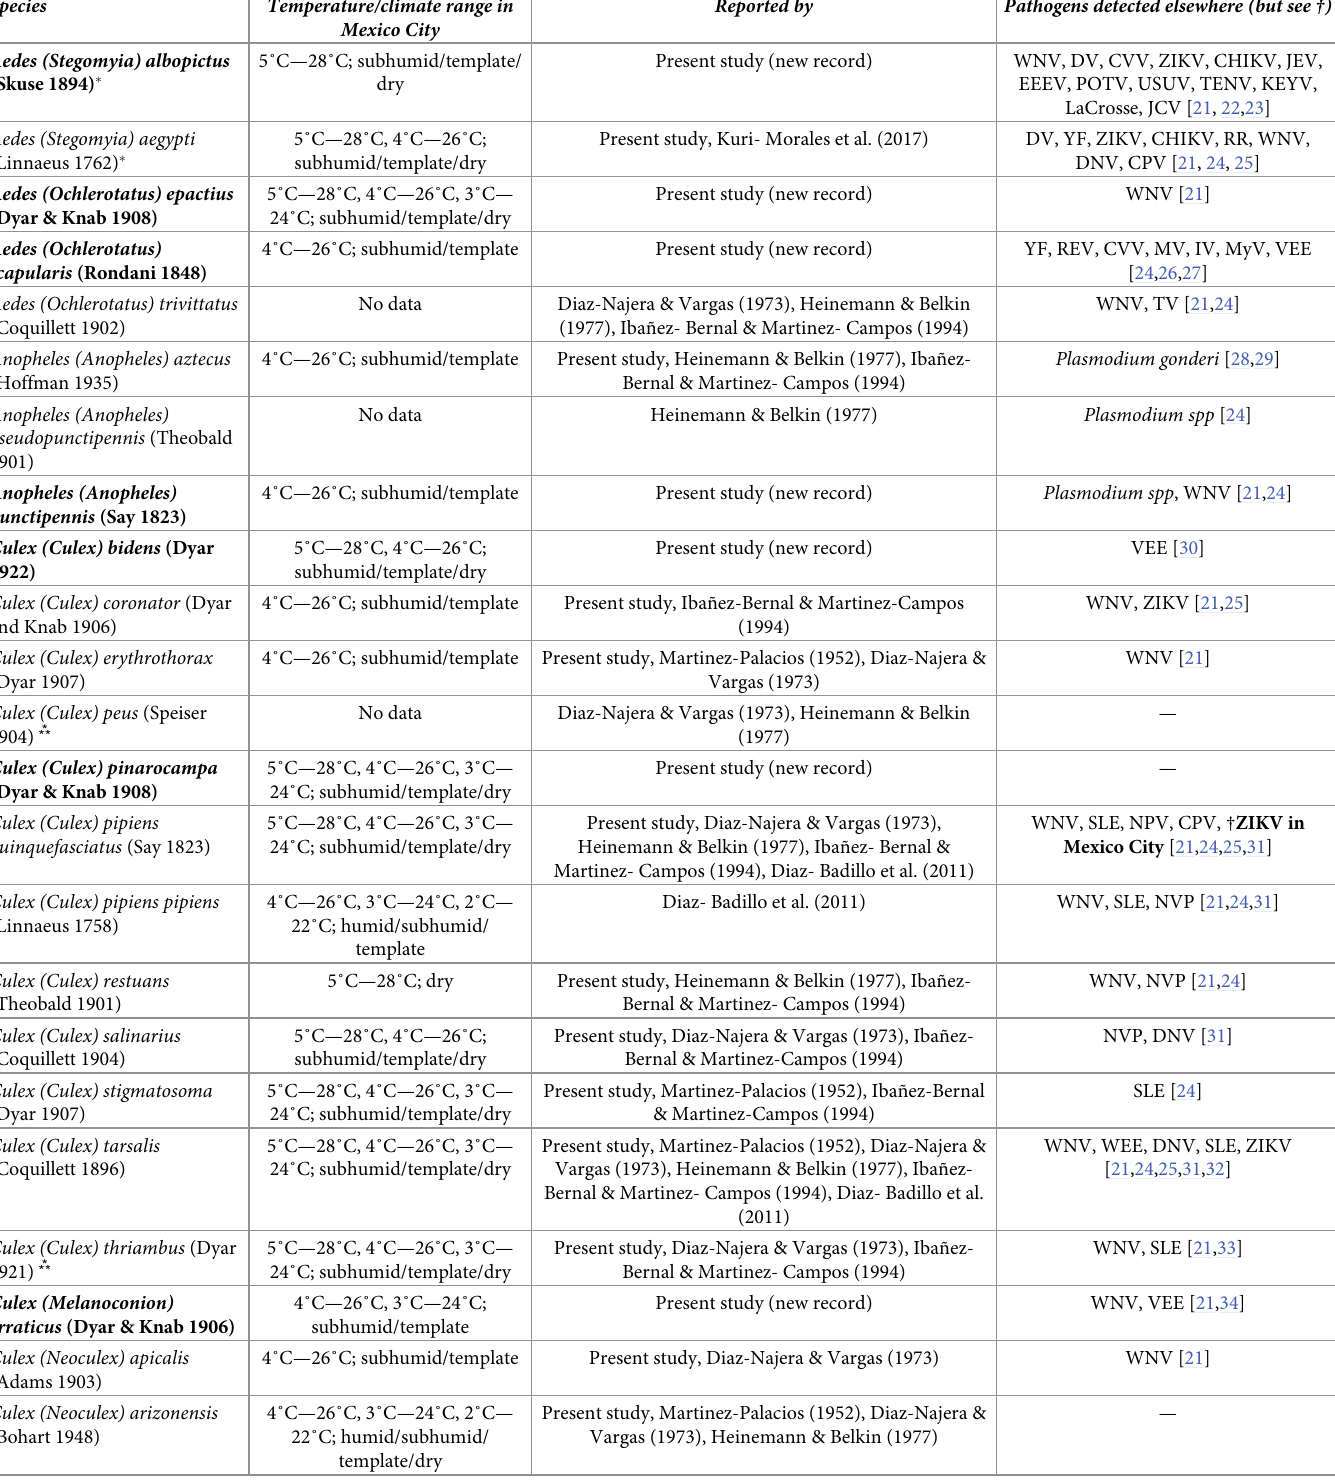
Table 2. Updated list of urban and semi urban mosquitoes collected in Mexico city.